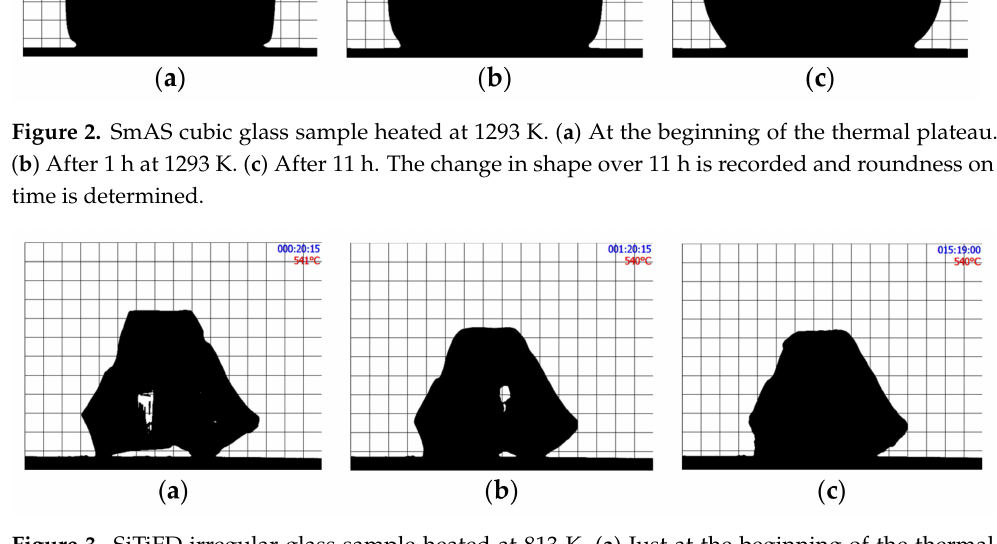
Figure 3. SiTiFD irregular glass sample heated at 813 K. ( a ) Just at the beginning of the thermal plateau. ( b ) After 1 h at 813 K. ( c ) After 15 h. The slight change in shape over 15 h is recorded as roundness on time, as shown in Figure 5. During heat treatment pictures, were taken every 15 s.